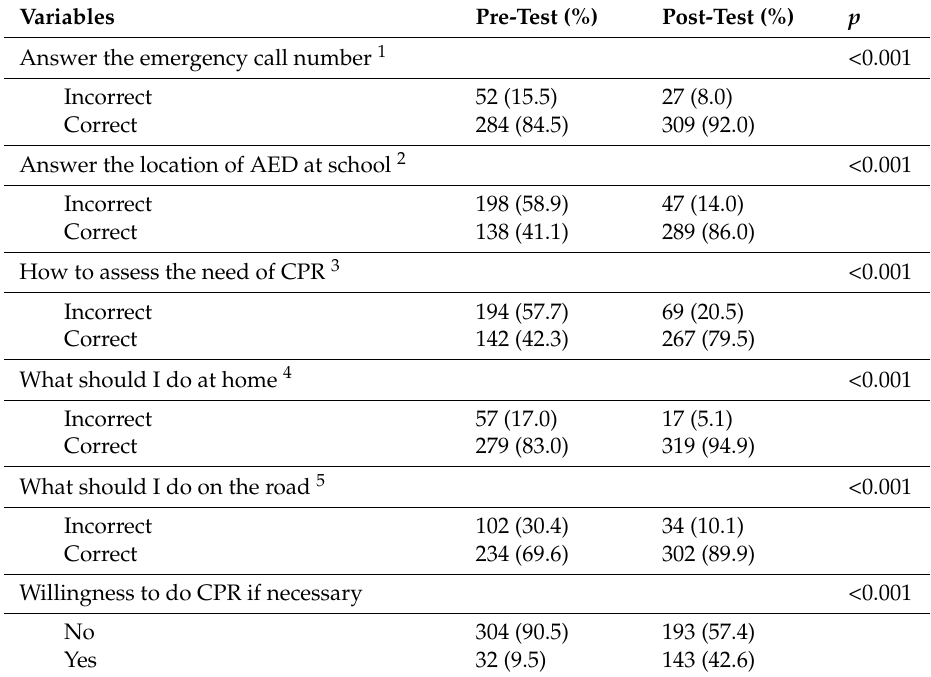
Table 2. Effects of knowledge and attitude change between pre-test and post-test (McNemar test, n = 336).